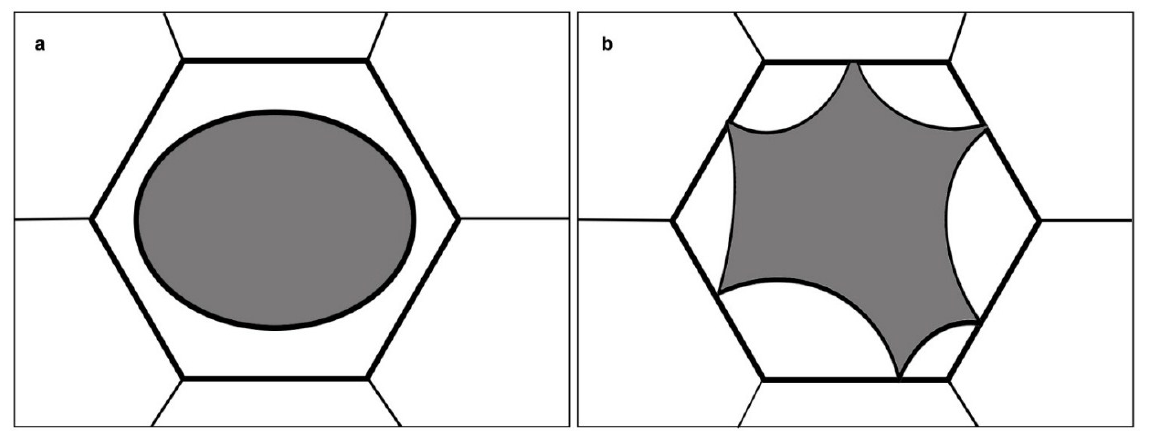
Figure 1. Schematic of the two major plasmolysis forms; ( a ) convex plasmolysis; ( b ) concave